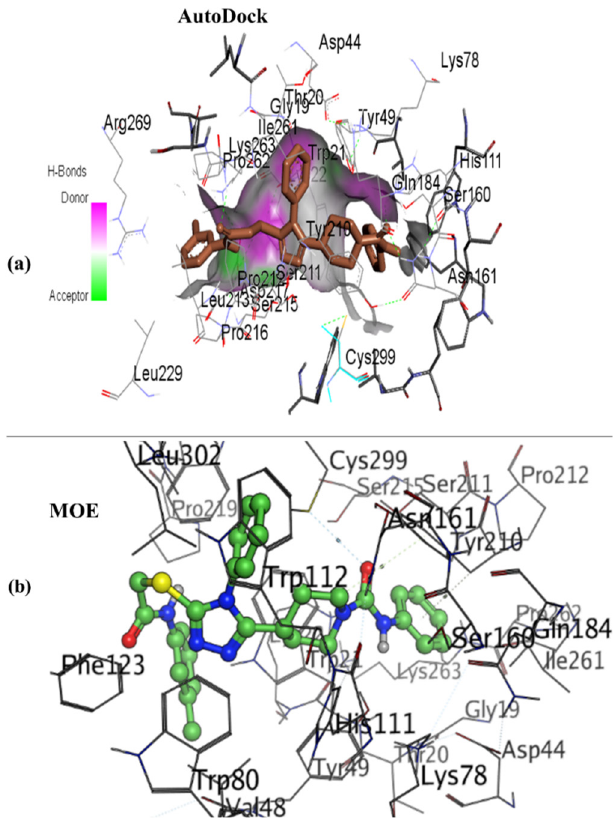
Figure 5. Docking conformations of the most potent compounds of target AKR1B1. ( a ) Compound 7f in pocket of AKR1B10 (visualization by AutoDock), ( b ) Compound 7f in pocket of AKR1B10 (visualization by MOE).